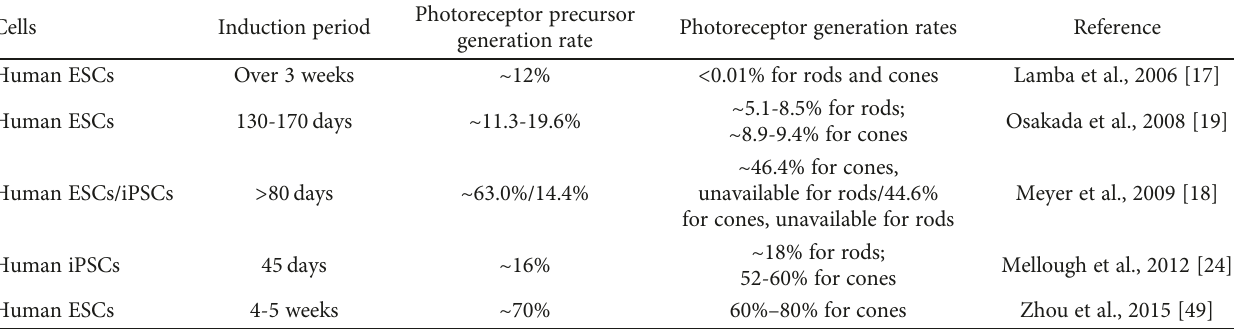
Table 1: Photoreceptor cells di ff erentiation in previous